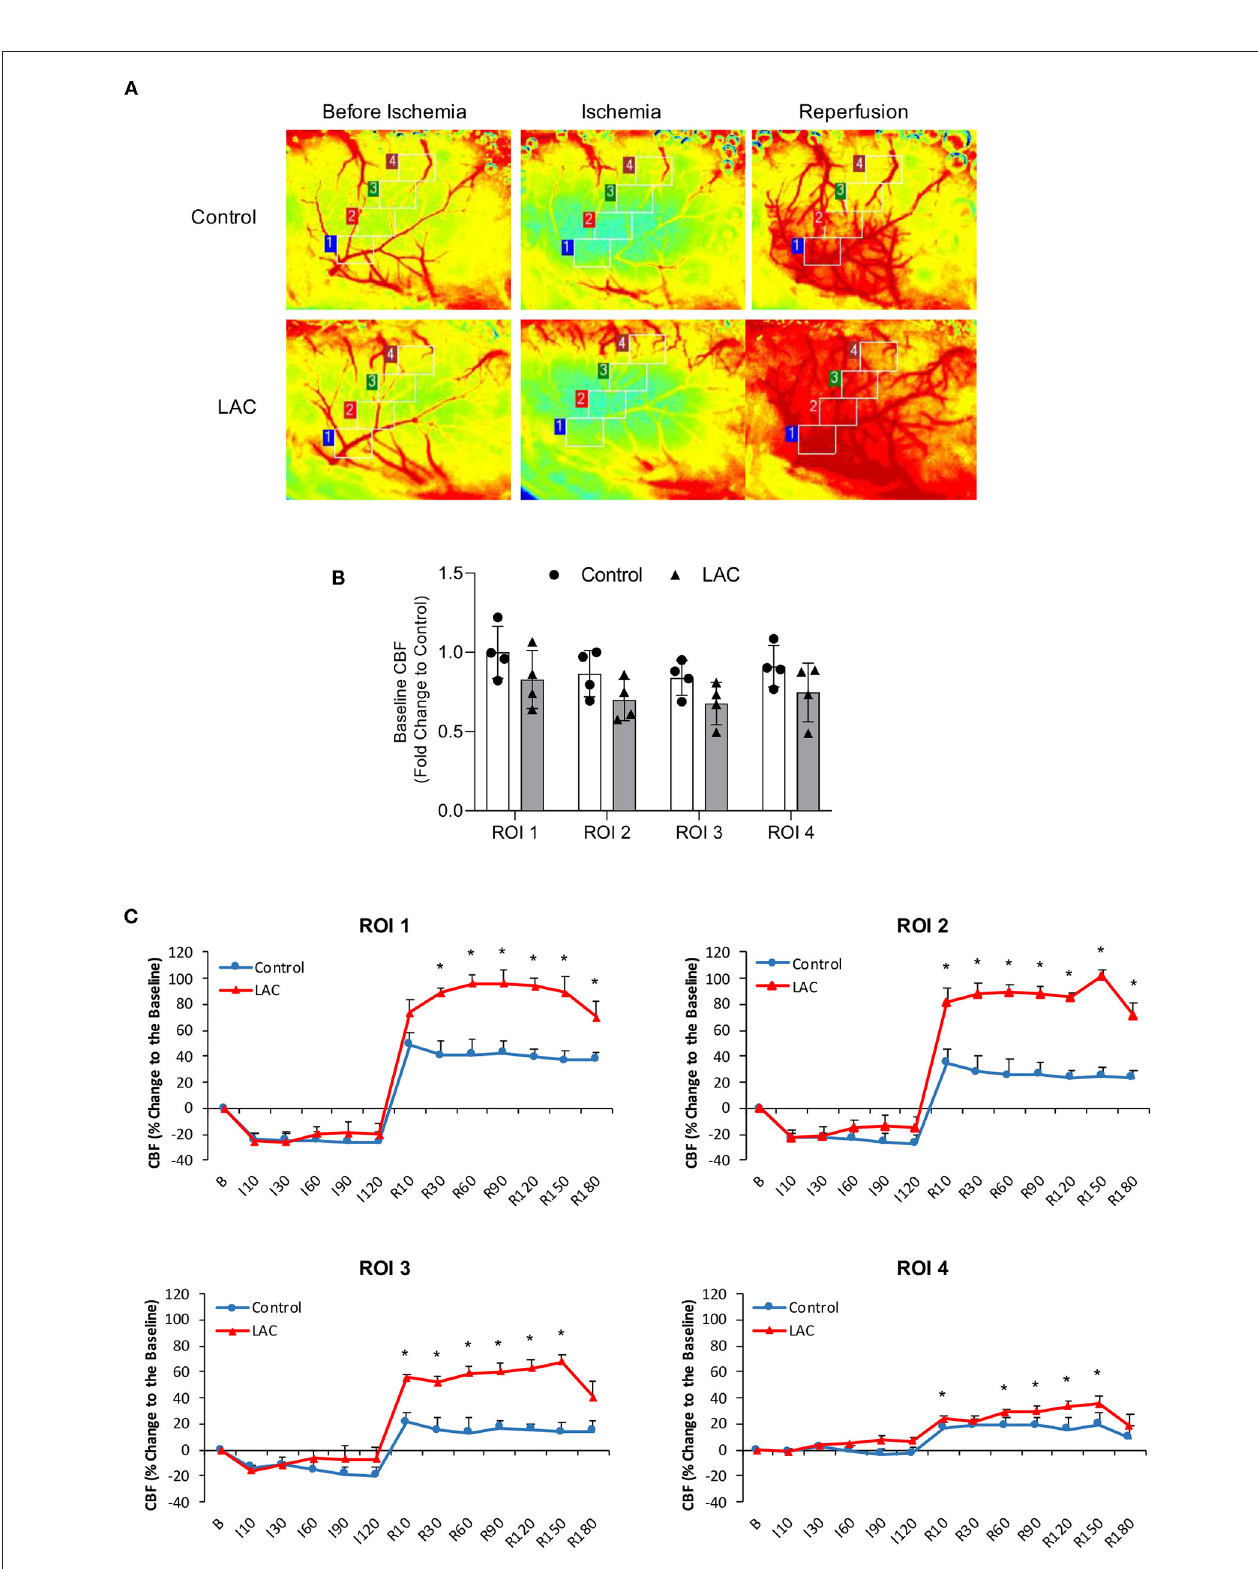
FIGURE 6 | Effect of LAC on rCBF during 2-h MCA ligation and 3-h reperfusion. (A) Representative laser speckle images of rCBF. (B) Baseline rCBF. Values are mean ± SD for four mice in each group. Analyzed using one-way ANOVA. (C) Percentage changes of rCBF to the baseline during ischemia and reperfusion. * P < 0.05 vs. Control. Analyzed using unpaired t